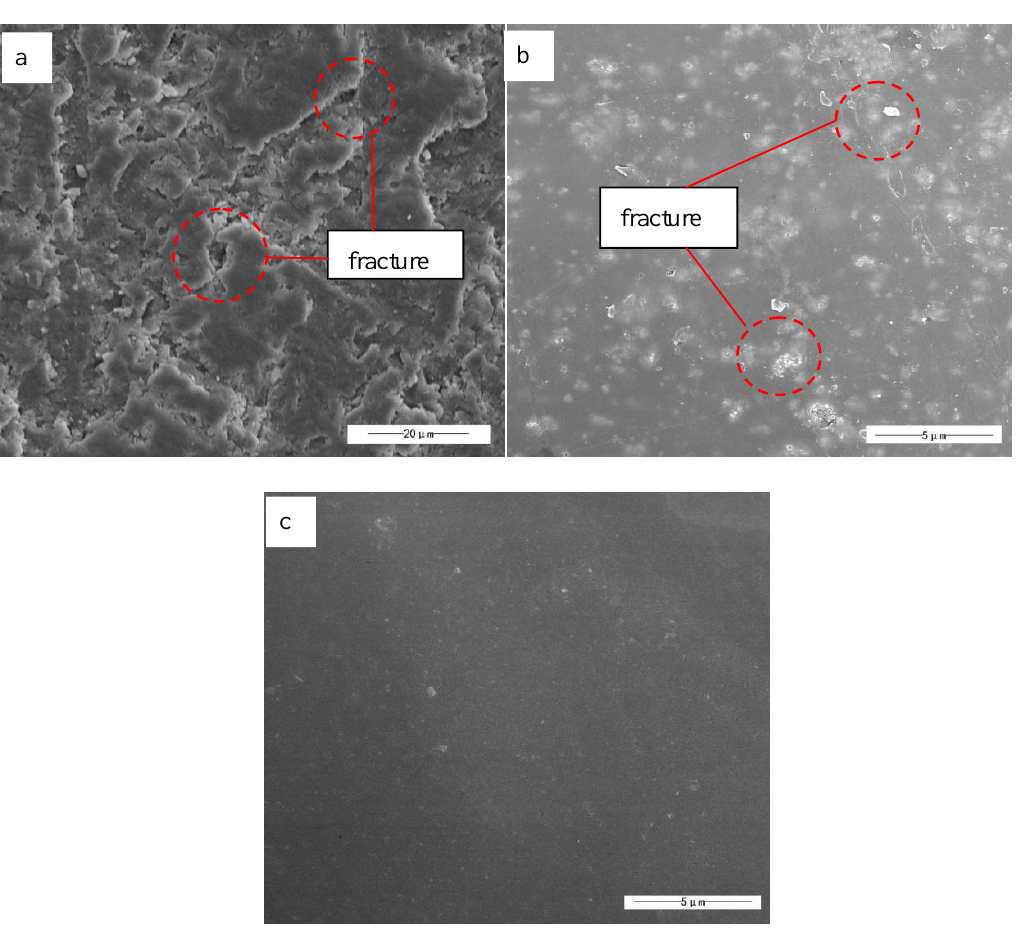
Figure 7. SEM of bare ZnO/UP ( a ), OA–APS–ZnO/UP ( b ), and CDI–OA–APS–ZnO/UP ( c ).